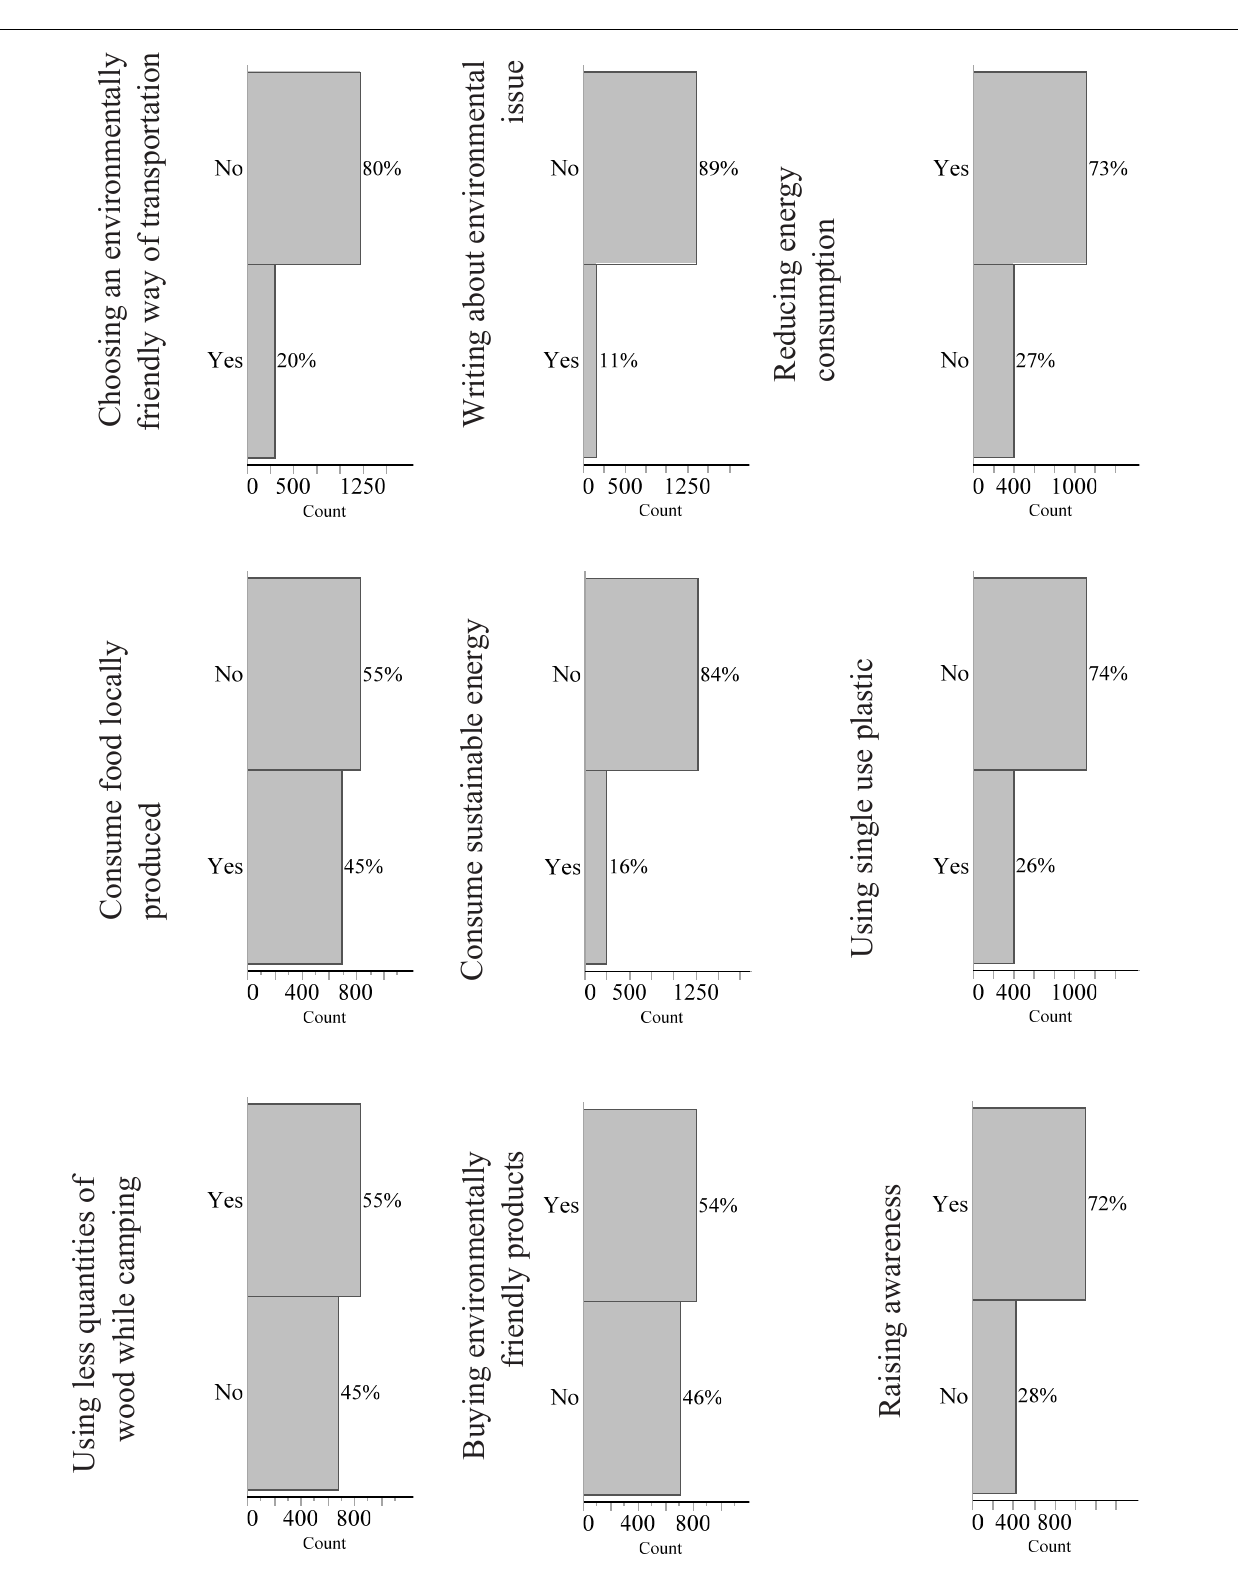
Frontiers in Marine Science |